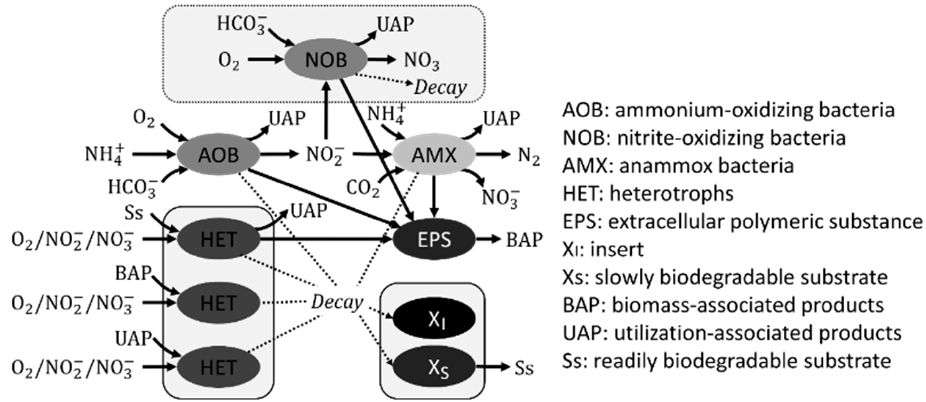
Figure 1. Schematic of biological conversion processes taken into account in the model.